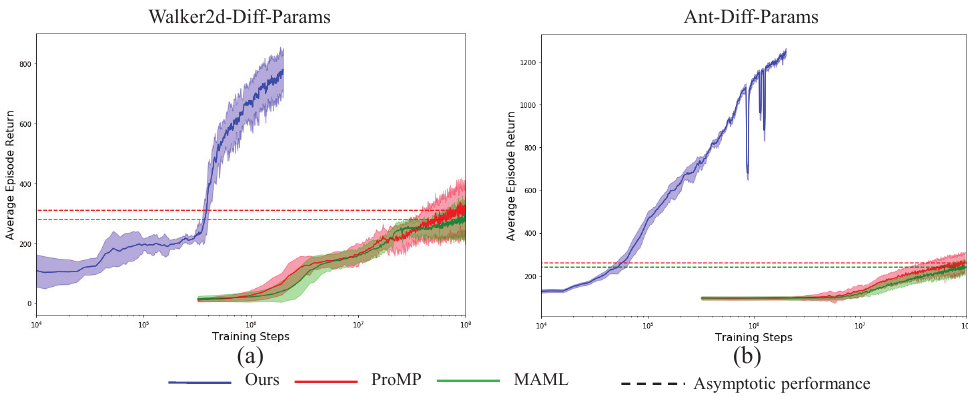
Figure 5. Performance comparisons for Walker2d ( a ) and Ant ( b ) with different physical parameters transfer learning